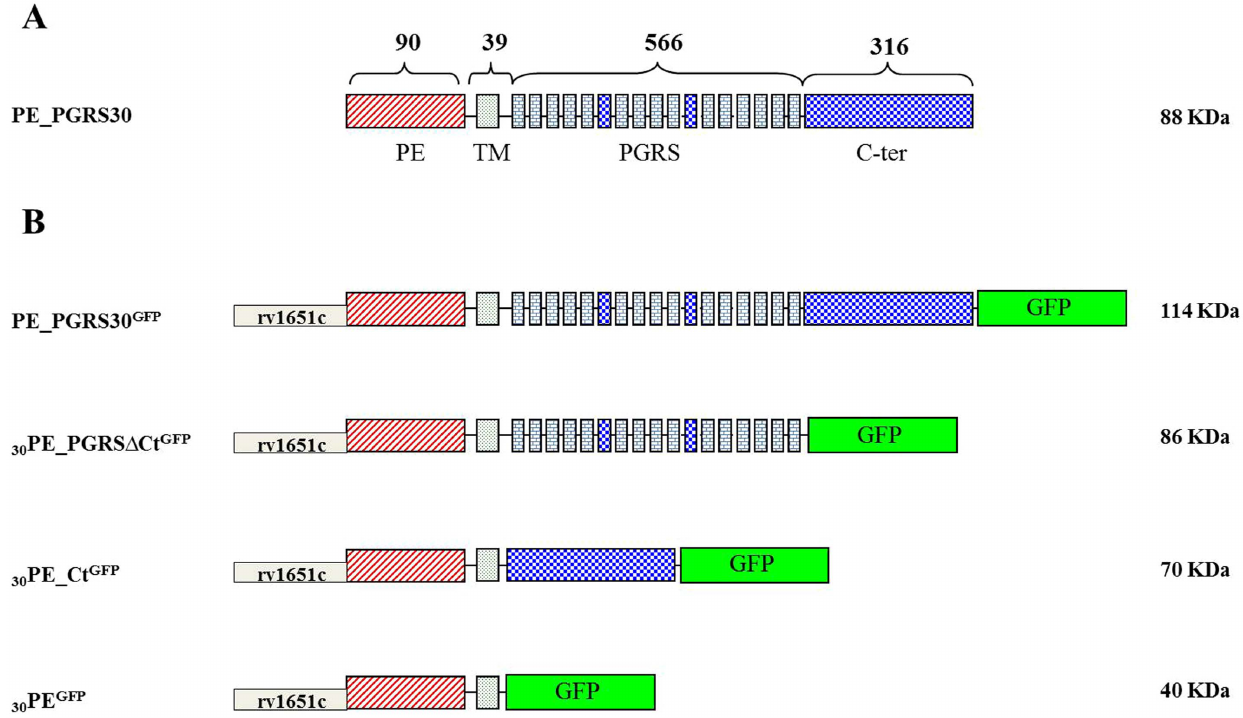
Figure 1. Scheme showing the constructs expressing PE_PGRS30 used in this study. Schematic representation of native full length PE_PGRS30 gene with the indication of the different protein domains (A). List of constructs generated in pMV206 and expressing the PE_PGRS30 functional chimeras, tagged with green fluorescent protein (B). The constructs were transformed in Mtb H37Rv, M. smegmatis and M. bovis BCG.